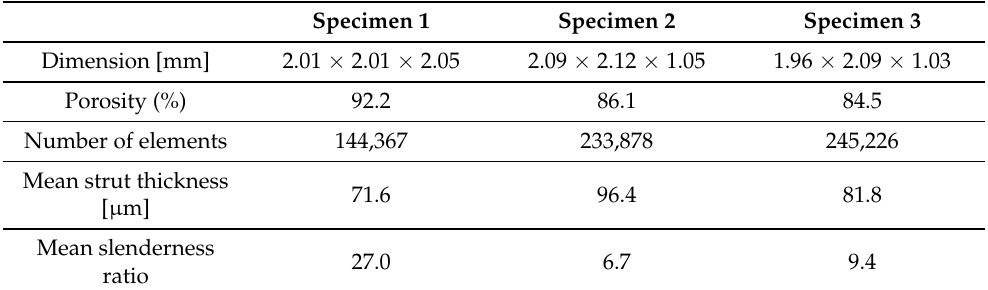
Table 2. Summary of microstructural features of various open-cell Ni foams, as shown in Figure